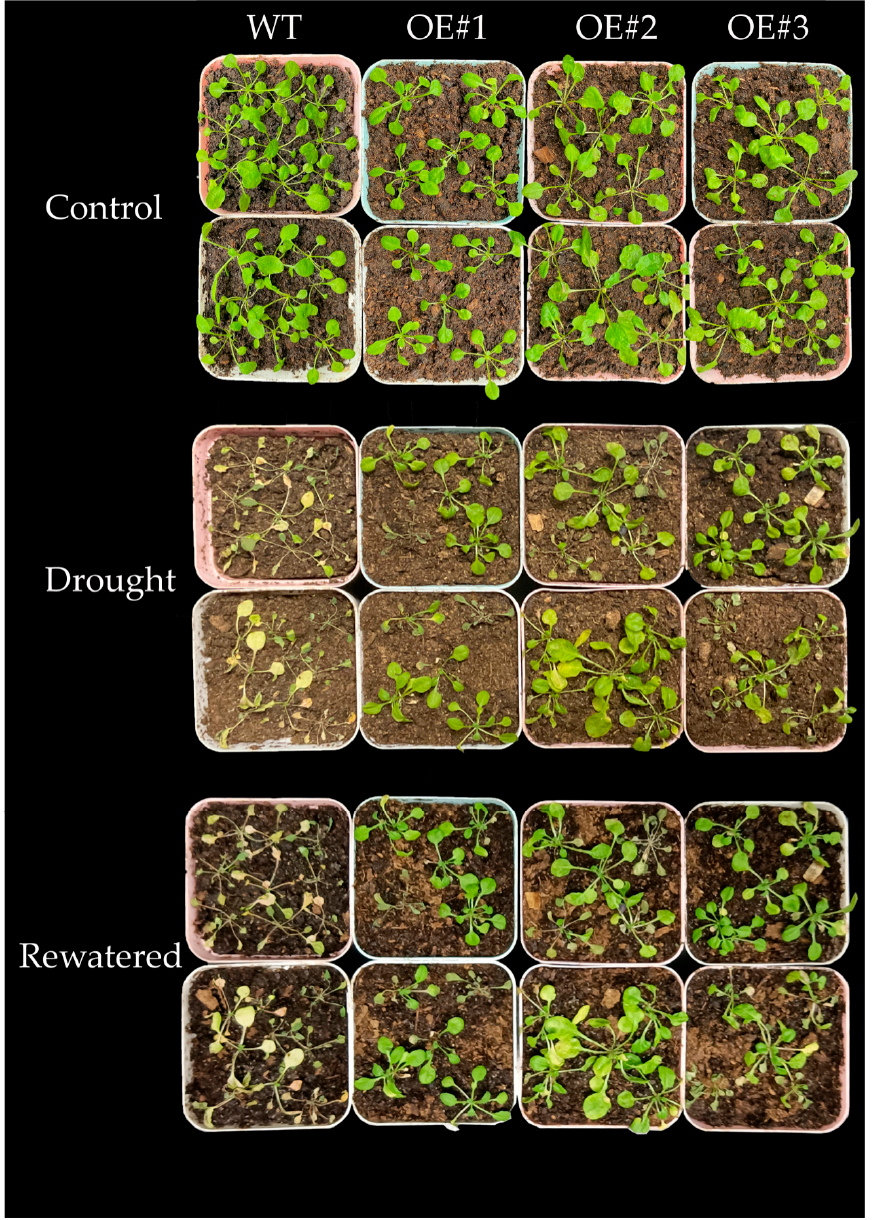
Figure 13. Effects of drought stress on the growth of Arabidopsis thaliana.